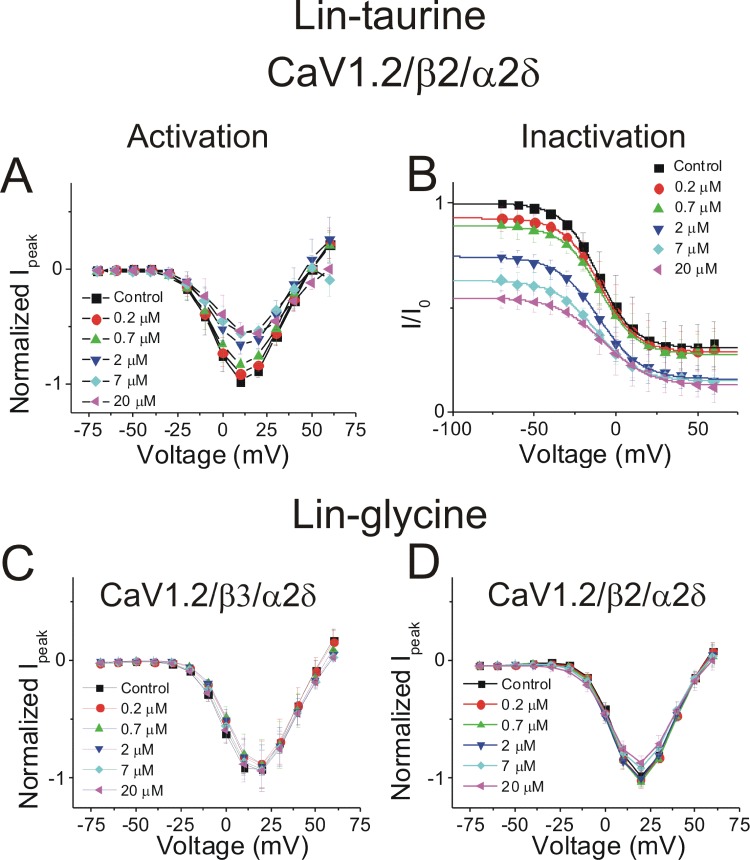
PUFA-induced effects on Cav1.2 expressed with β-subunit β2 and α2δ (Cav1.2/β2/α2δ).(A) Voltage dependence of activation for Cav1.2/β2/α2δ in the presence of Lin-taurine. (B) Voltage dependence of inactivation for Cav1.2/β2/α2δ in the presence of Lin-taurine. (C–D) Comparison between the voltage dependence of activation for (C) Cav1.2/β3/α2δ and (D) Cav1.2/β2/α2δ in the presence of Lin-glycine.